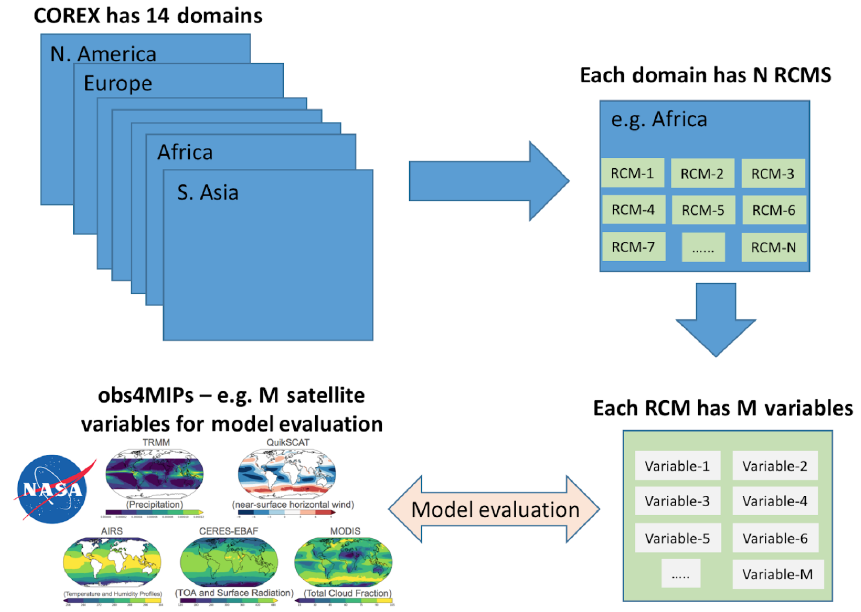
Figure 5. The multi-model, multi-variable evaluation against satellite observations from obs4MIPs over the 14 CORDEX